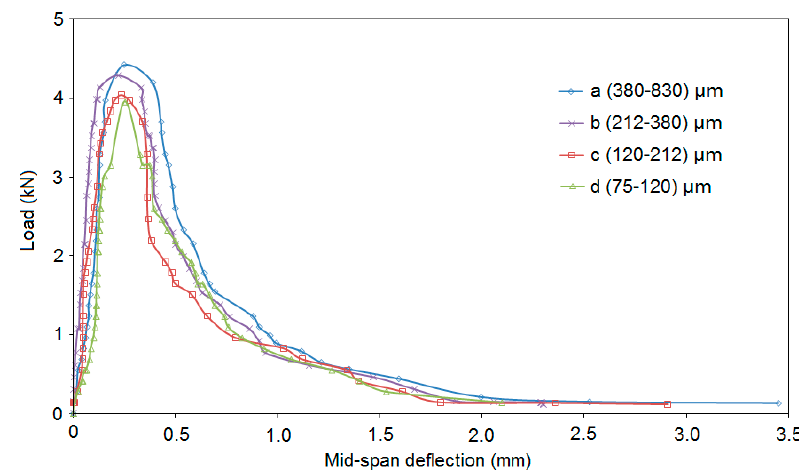
Figure 11. Relationship between load and mid-span deflection.